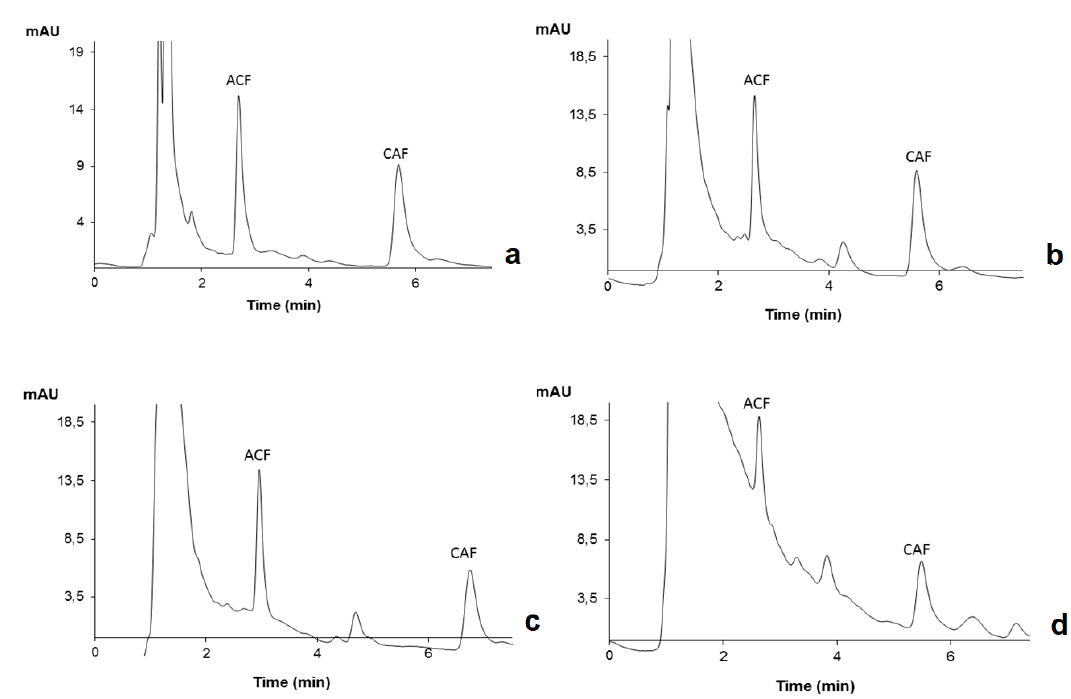
Figure 6. Chromatograms obtained from assays performed on ultra-pure water ( a ), superficial water ( b ), sea water ( c ), and urban wastewater ( d ) by MSA µ E(AC(R))-LD/HPLC-DAD under optimized ( b ), sea water ( c ), and urban wastewater ( d ) by MSAµE(AC(R))-LD/HPLC-DAD under optimized experimental experimental conditions.